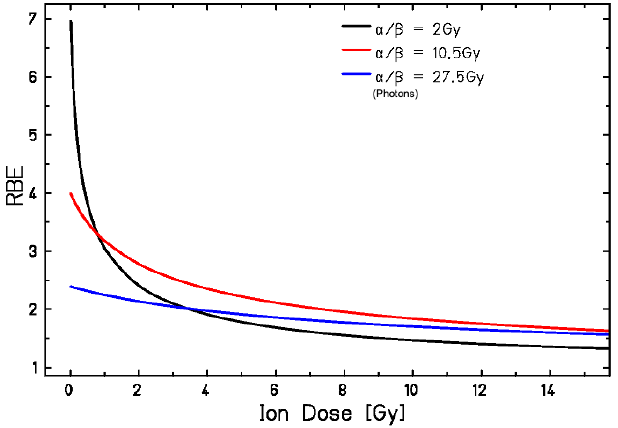
Figure 9. RBE of C-ions as a function of the dose per fraction calculated with the liner quadratic model for different  values. Figure from reference [96], reproduced with permission by